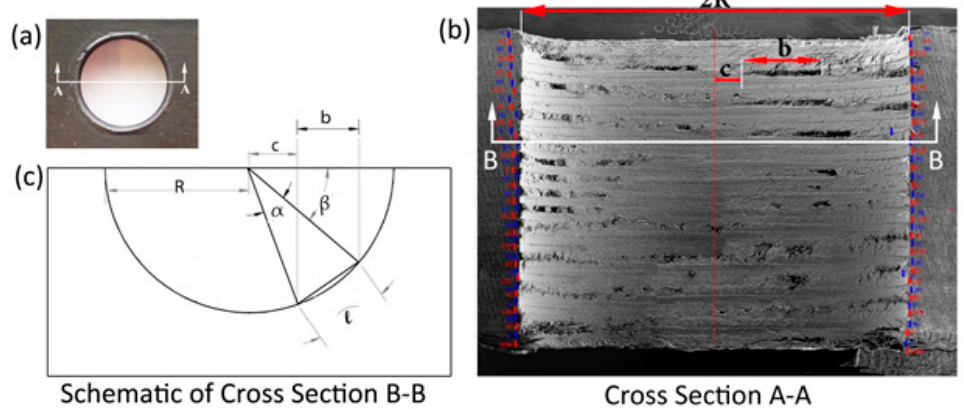
Figure A1. Fiber pull out length measurement technique on cross section of hole. ( a ) Top view-hole entrance; ( b ) SEM image of cross section A–A; ( c ) Schematic of cross section B–B and fiber pull out length measurement method.